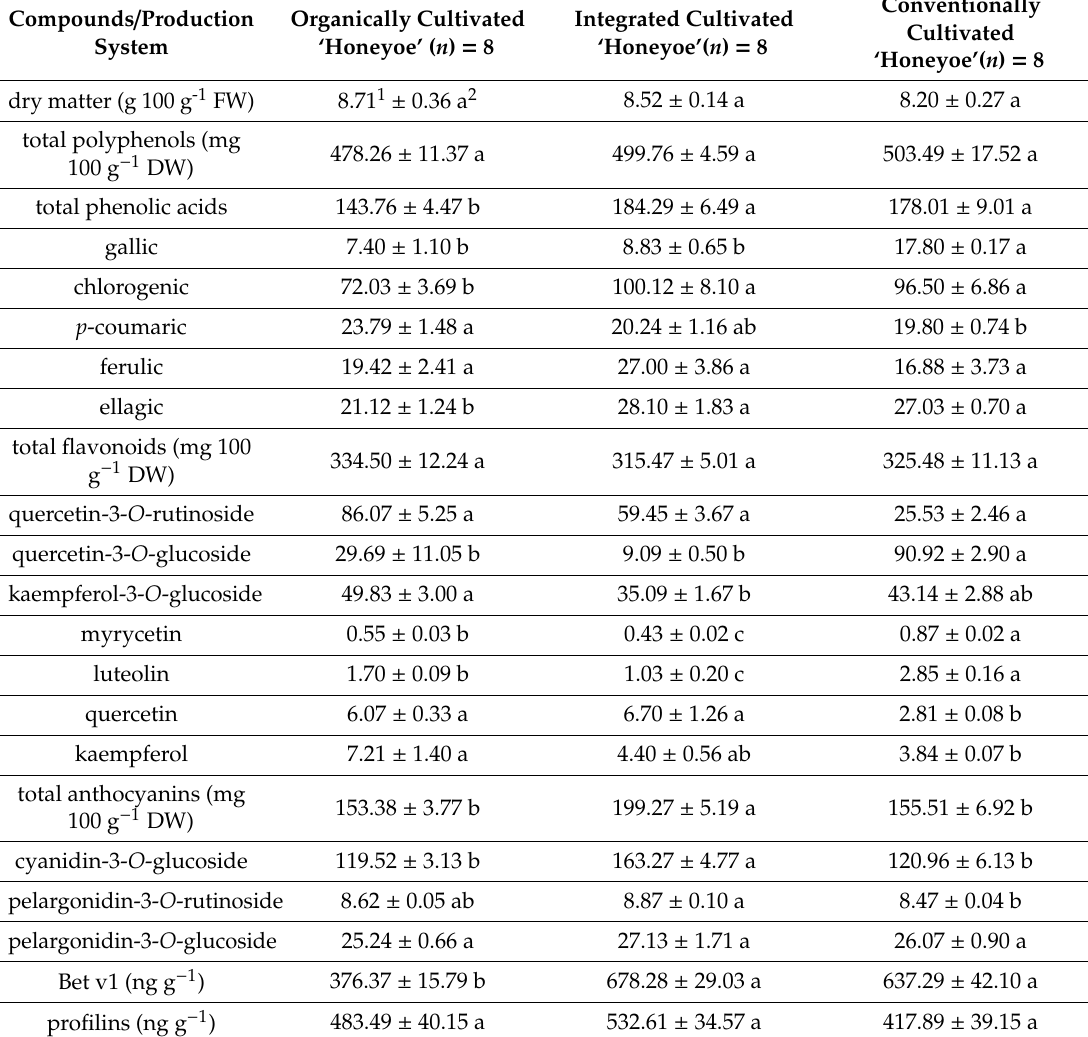
Table 2. The content of dry matter, phenolics compounds, Bet v1 and profilins in experimental strawberry from three cultivation